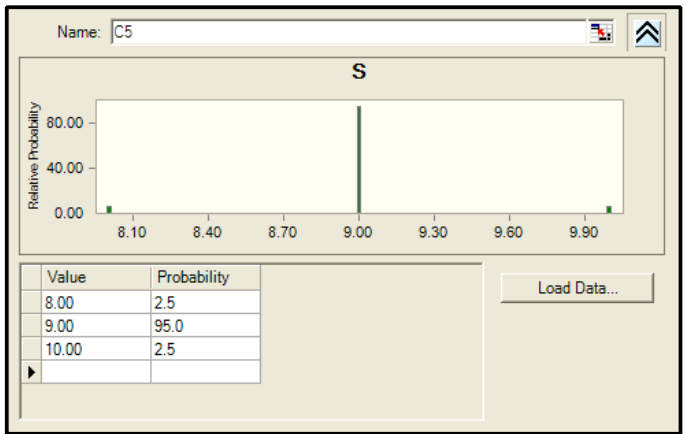
Figure 9. Case 1: Discrete nonuniform distribution of S in CB software.